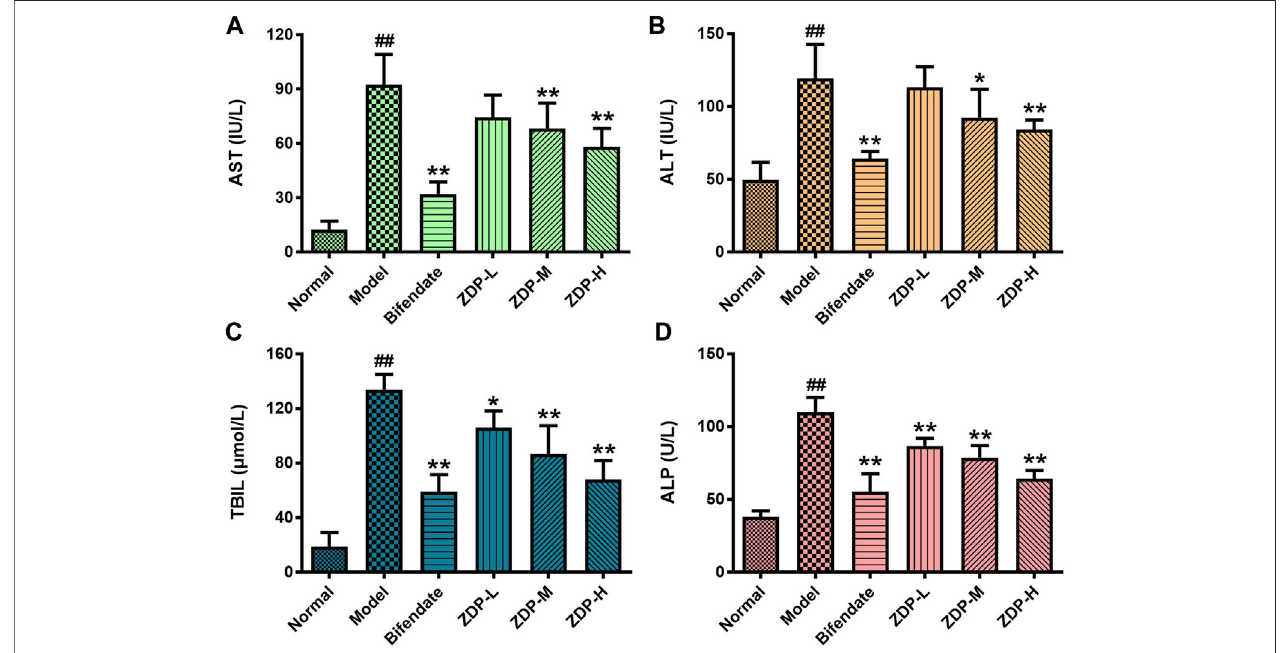
FIGURE 4 | ZDP decreases the activities of serum AST, ALT, TBIL and ALP in the murine model of ALI induced by CCl 4 . AST (A) , ALT (B) , TBIL (C) and ALP (D) activitiesweremeasuredinmouseserumsamples(Normalcontrol,Modelcontrol,Bifendate-treatedcontrol,ZDP-L,ZDP-MandZDP-H)byELISA.Datafromsixtoeight miceper groupareexpressedasthemean ± SD.Statisticalanalysis: ## p < 0.01comparedwiththenormalgroup;* p < 0.05,** p < 0.01compared withthemodelgroup, One-Way